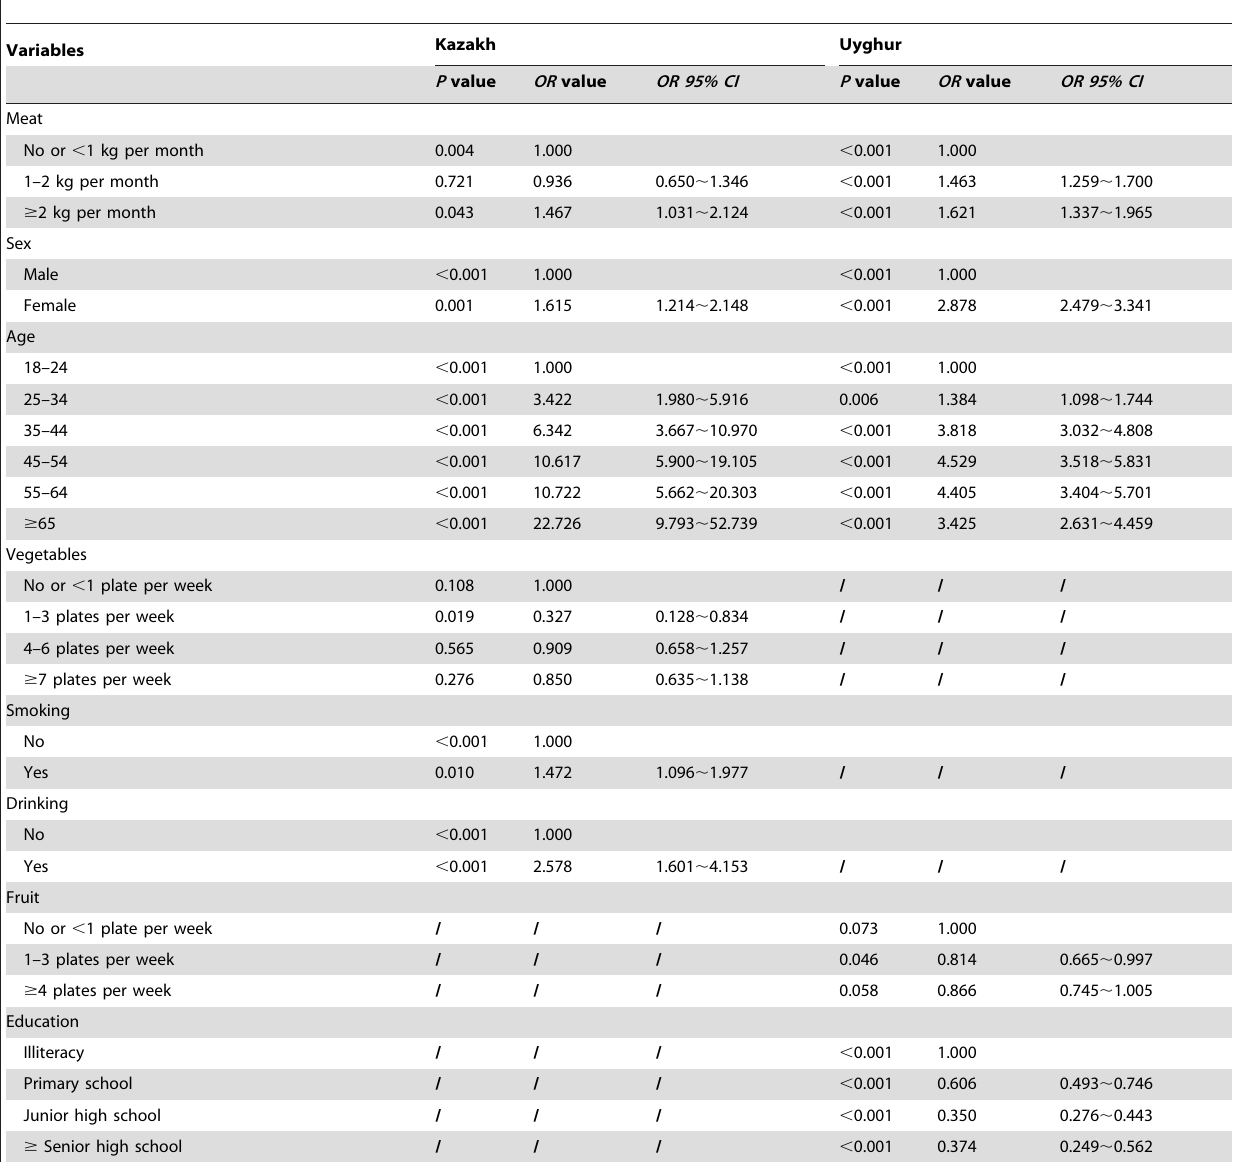
Table 3. Factors associated with the difference prevalence of obesity from multivariate logistic regression models in Kazakh and Uyghur rural